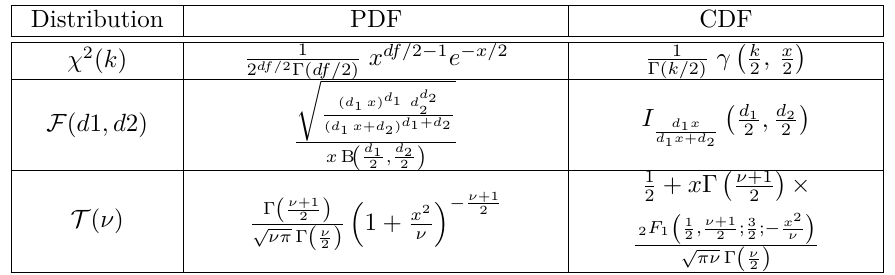
Table 2: The PDF’s and CDF’s of the considered distributions.